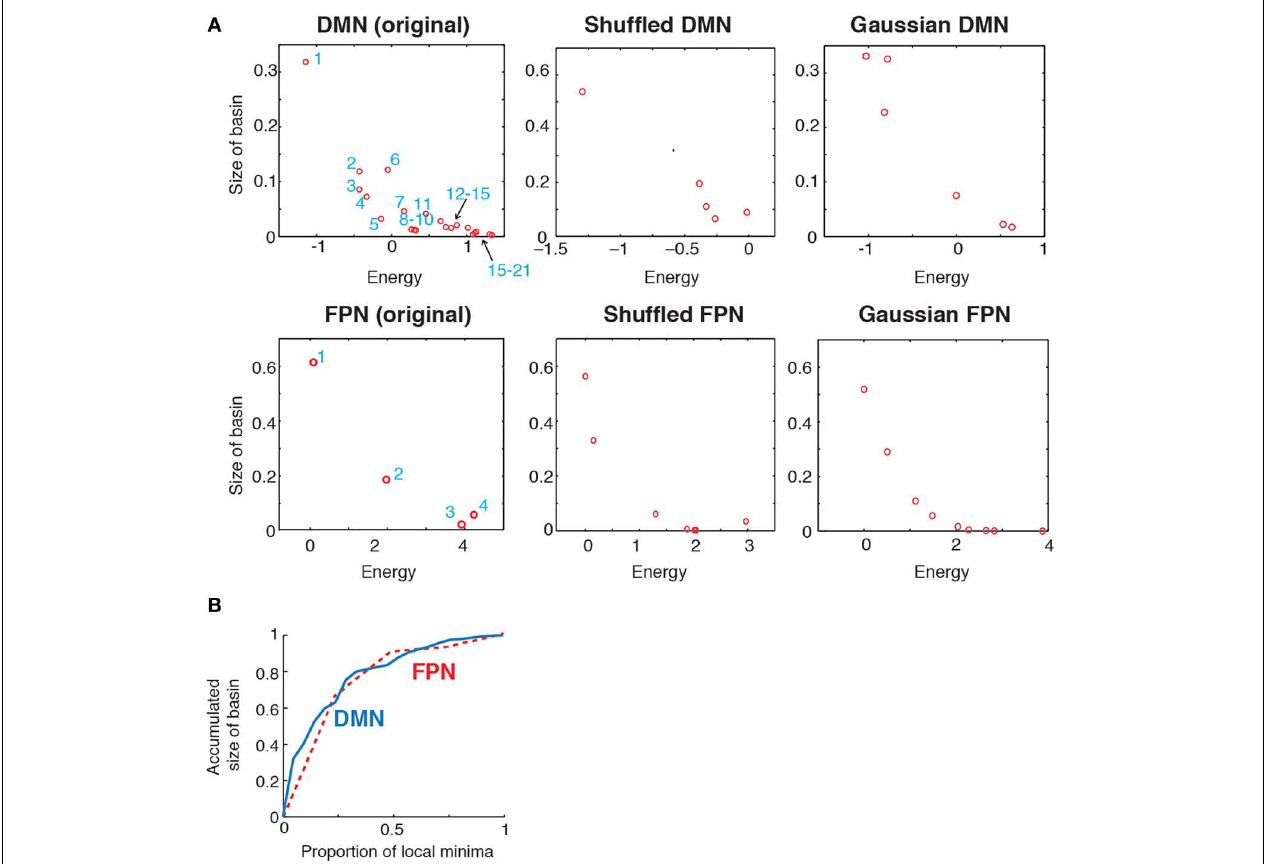
FIGURE 4 | (A) Relationship between the size of basin and the energy of local minima. In the two panels on the left, the numbers indicate the IDs of local minima used in Figure 2 . (B) Accumulated size of the basin for the local minima. The vertical axis shows the fraction of the network states that